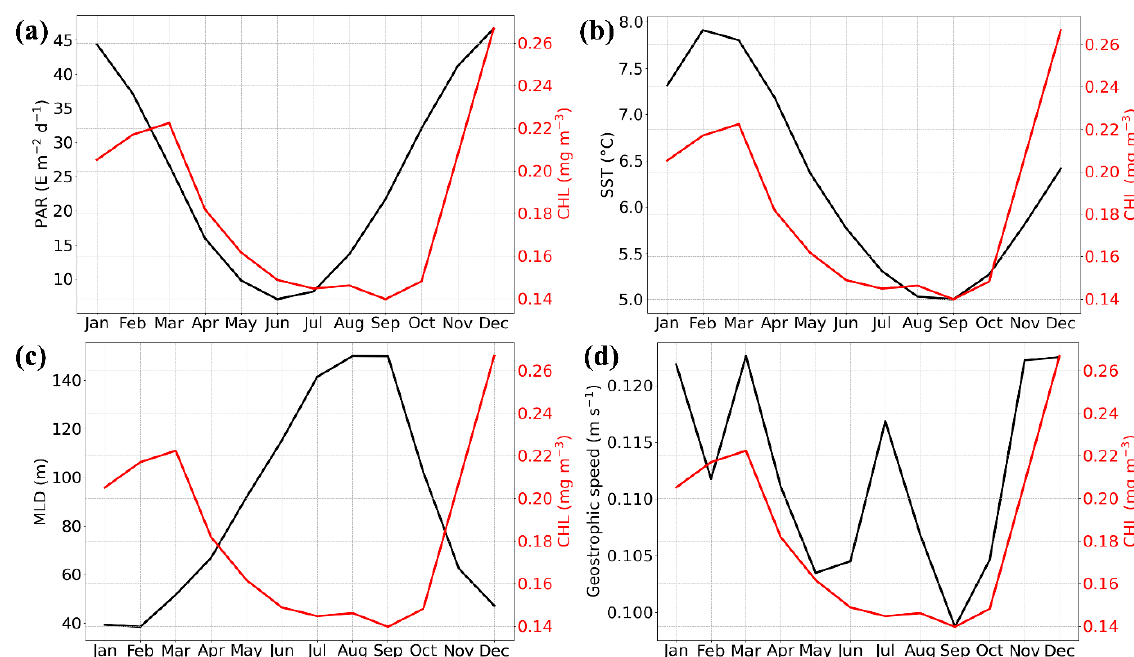
Figure 5. Monthly climatological means of chlorophyll a (chla; mg m − 3 ), indicated in red, and ( a ) Photosynthetically Available Radiation (PAR; E m − 2 d − 1 ), ( b ) Sea Surface Temperature (SST, ◦ C), ( c ) ORAS5 Mixed Layer Depth (MLD; m), and ( d ) geostrophic current speed (m s − 1 ) (shown in black), extracted and averaged over the region (45.5–46.5 ◦ S; 38–39 ◦ E) encompassed by the long-term mean 0.18 mg m − 3 chla isopleth northeast of the Prince Edward Islands.